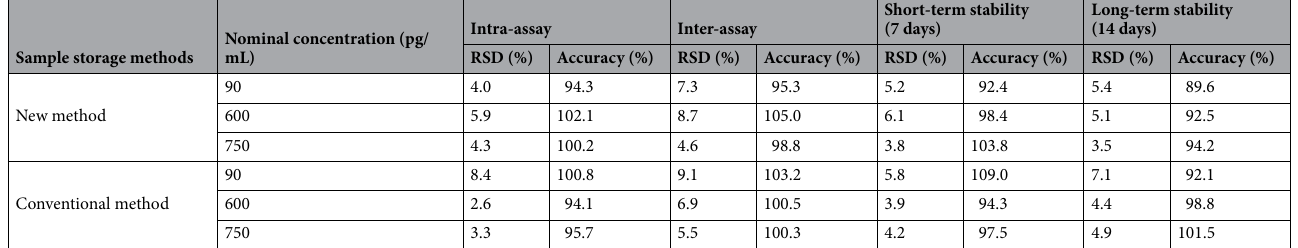
Table 1. Intra- and inter-day accuracy and precision, and stability of adalimumab.